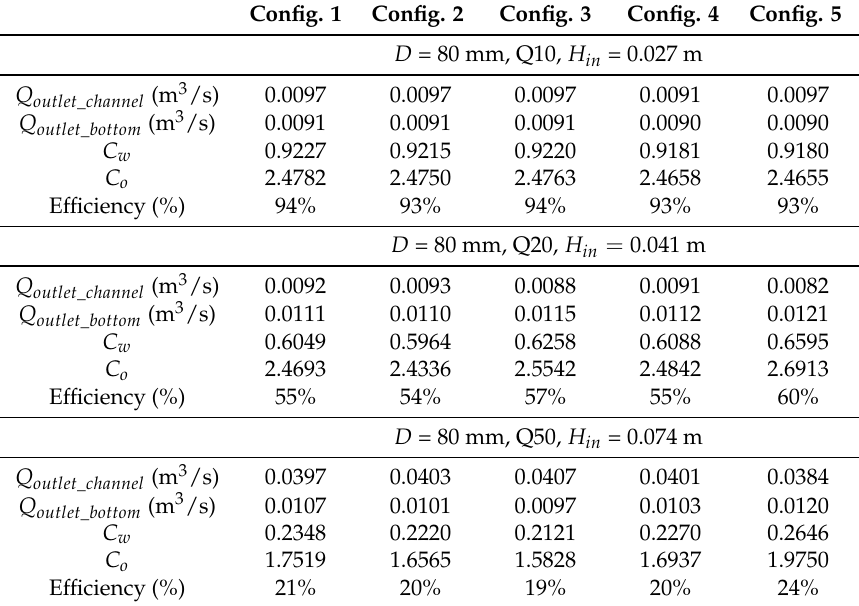
Table 8. Discharges, coefficients and efficiency for gullies with different bottom outlet location ( D = 80 mm).